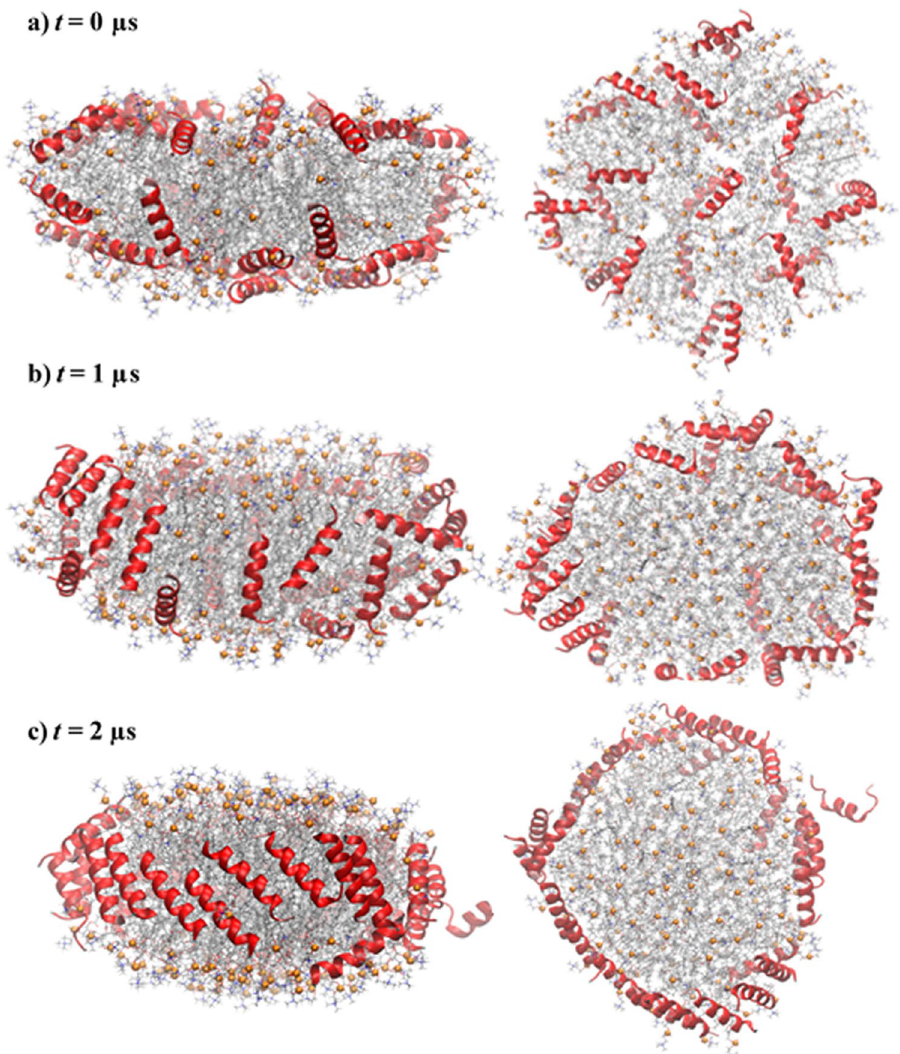
Figure 8. Picket-fence arrangement of neu on a HDL nanodisc. Stoichiometry of phospholipids, cholesterol and peptides was the following: 150:15:24 POPC:chol:neu. Left panels, side views; right panels, top-down views. ( a ) t = 0 μ s. Peptides are initially placed on disc surface randomly. ( b ) t = 1 μ s. 14 out of 24 peptides migrated to disc edge. ( c ) t = 2 μ s. Peptides are initially arranged in a “picket-fence” orientation. Peptides are shown in red ribbons. POPC and cholesterol are represented as sticks: acyl chain, silver ; nitrogen, blue , oxygen, red ; phosphorus, orange balls; cholesterol carbons, black